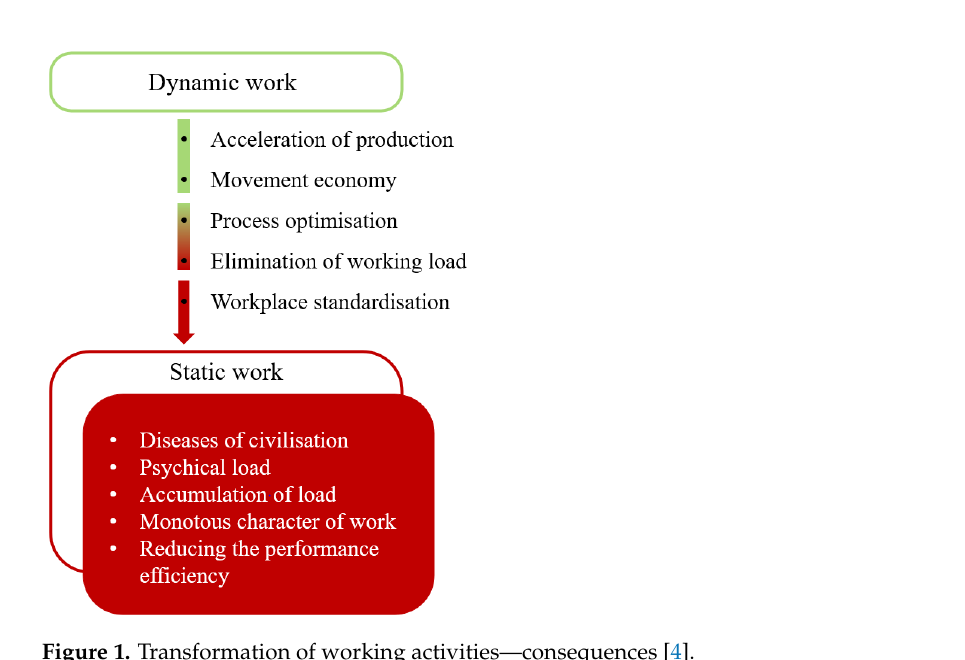
Figure 1. Transformation of working activities — consequences [4].